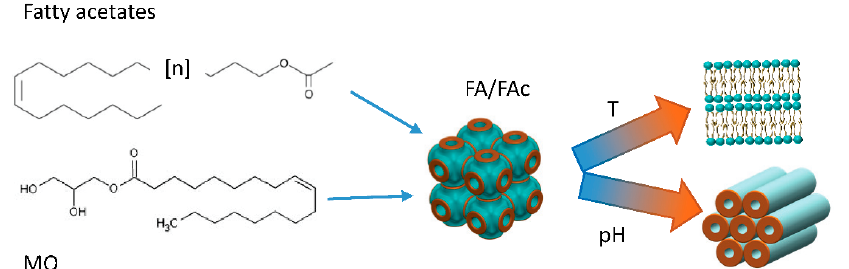
Figure 3. Cartoon representing the experiment reported in [35]. The phase transition from